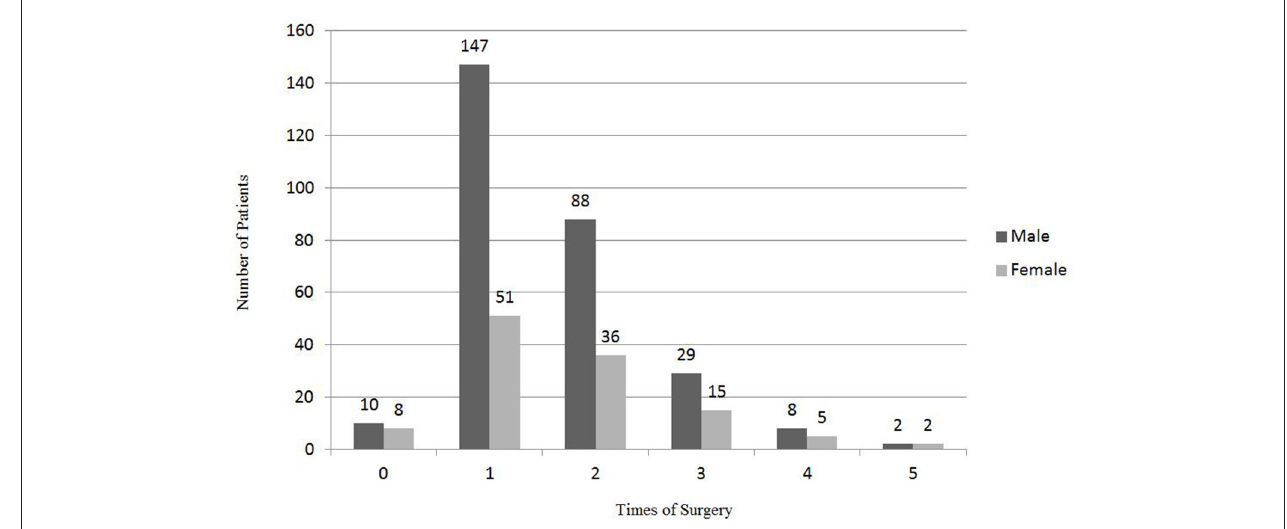
FIGURE 5 | Distribution of gender and times of surgery for pediatric